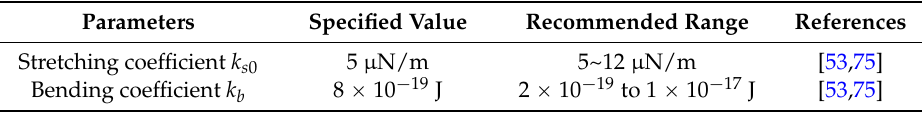
Table 1. Cell membrane model parameters.